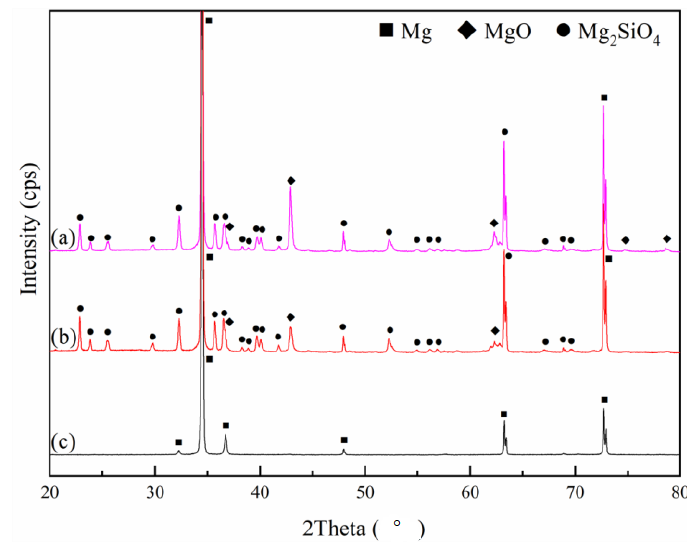
Figure 6. X-ray diffraction (XRD) patterns of PEO coatings and substrate: ( a ) 10 g/L CNT PEO coating; ( b ) 0 g/L CNT PEO-coating; and ( c ) AZ31 Mg substrate.